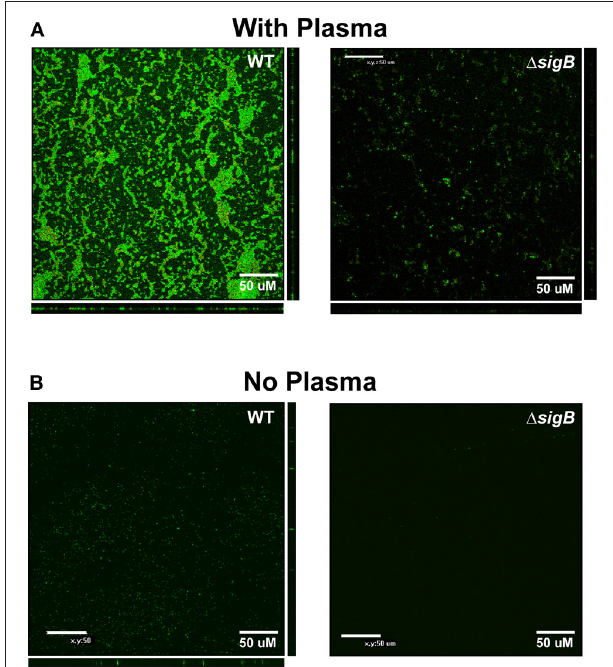
FIGURE 2 | CLSM Images of coverslip biofilms. LAC WT and LAC (cid:2) sigB mutant biofilms were grown on human plasma-coated coverslips (A) or untreated coverslips (B) . The biofilm were post-stained with SYTO9 (green) and TO-PRO3 (red), and a z series of images was obtained with CLSM to visualize biofilm capacity. Each image shows a larger top down (XY) view with cross-section views of biofilm depth on the right (YZ) and bottom (XZ). Only top down (XY) images were taken of LAC (cid:2) sigB grown on plastic due to the lack of cell adherence. Biofilms did not form in the media only control wells (not